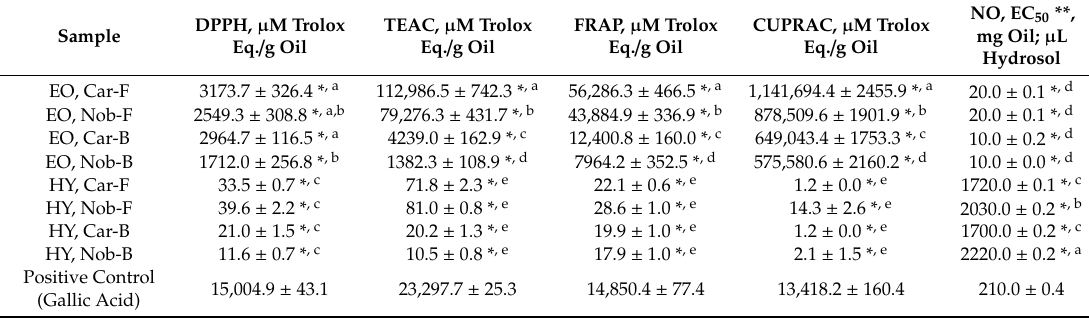
Table 2. Antioxidant activities of essential oils and hydrosols from two M. rotundifolia (Michx.) Small.